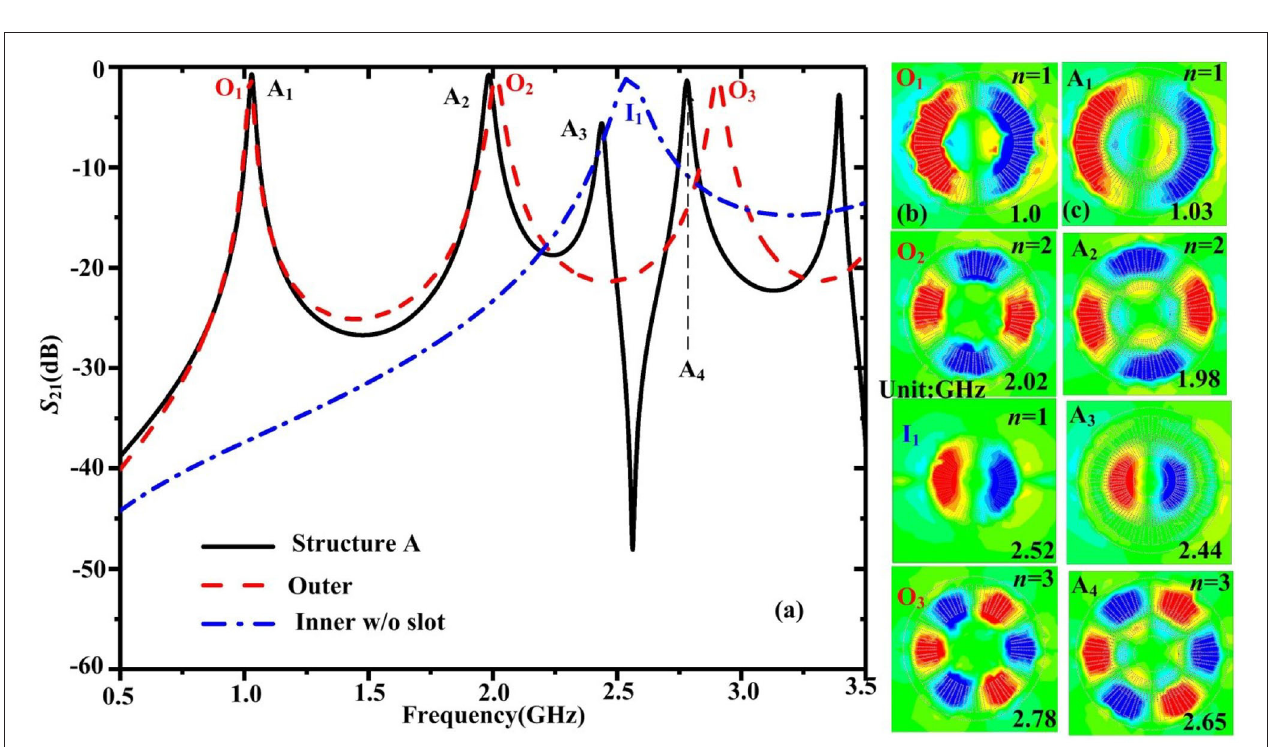
FIGURE 2 | (a) Simulation transmission coefficients S 21 of Structure A, outer corrugated ring, and inner corrugated ring. Two-dimensional E z -field distributions on the xoy plane 2mm above (b) the spoof localized surface plasmon (LSP) resonators and (c) Structure A.